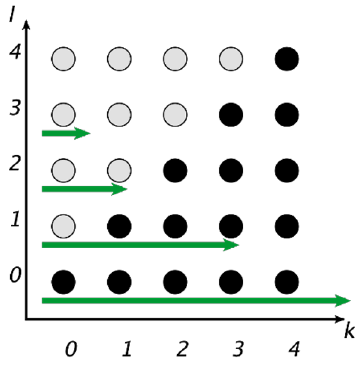
Figure 8 . The structure of the c ( k,l ) coefficients. Black blobs correspond to the divergent J sums. Grey blobs correspond to the finite J sums. Green arrows indicate the c ( k,l ) coefficients reproduced using relations (4.18) and